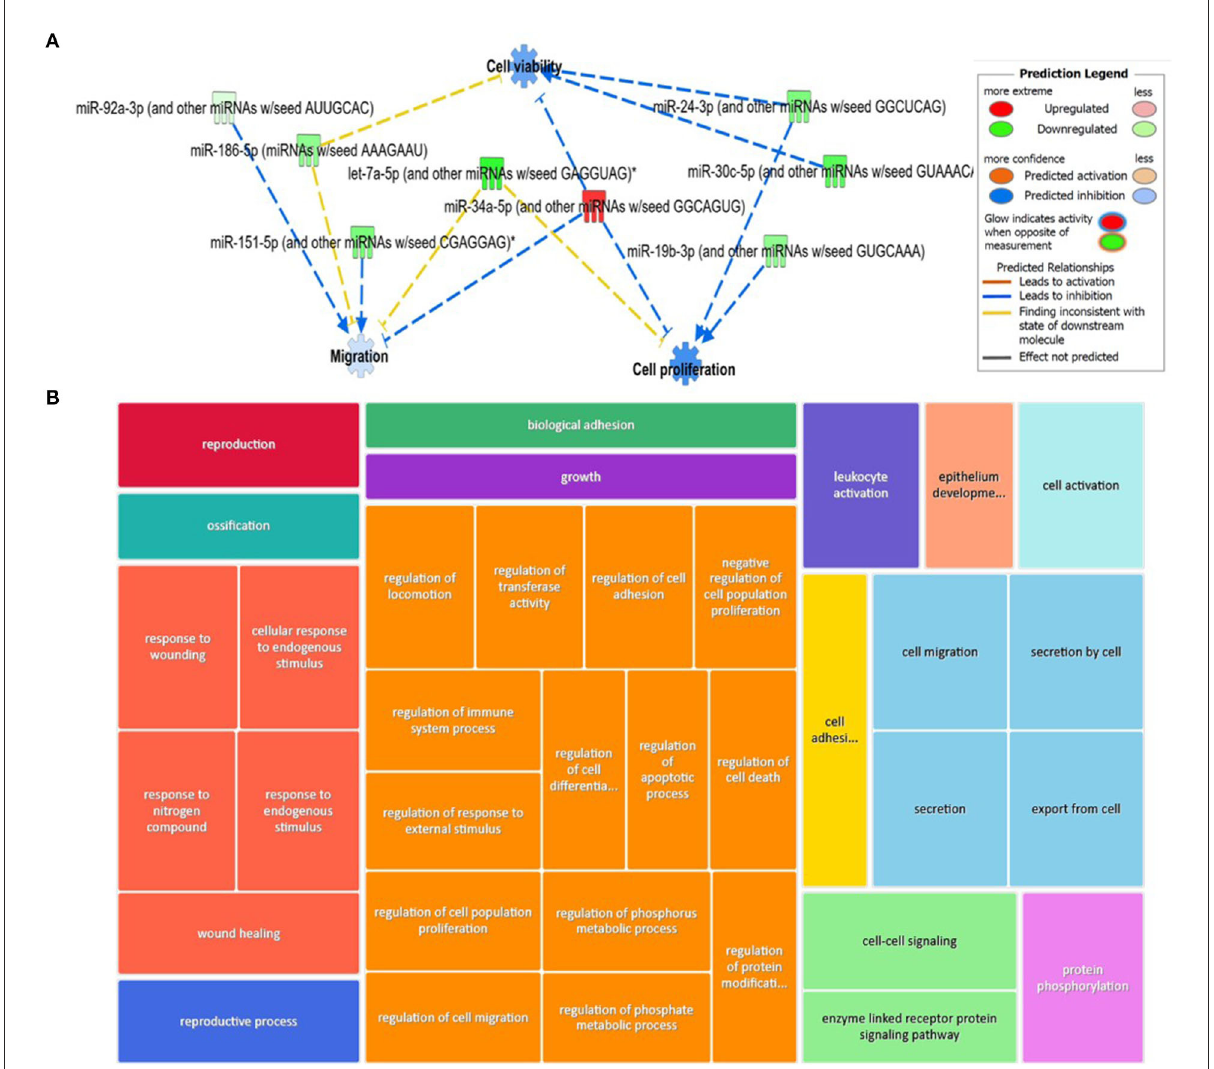
FIGURE9 Bioinformatics analysis of the differentially expressed (DE) plasma-derived EV miRNAs following small RNA sequencing and their putative mRNA targets. (A) IPA of the 27 DE miRNAs following all pairwise comparisons compared to day 0 showed that cell viability, proliferation, and migrations were activated. (B) Treemap of the top 100 GO terms. Hierarchical level is represented by a different coloured rectangle (branch), each containing smaller rectangles (leaves). The size of the space inside each rectangle is based on the measured value. GO biological processes associated with dysregulated miRNA targets were identified following the TargetScan philtre module in IPA. ToppGene was used to perform a functional enrichment analysis of predicted miRNA targets to highlight biological processes most significantly affected